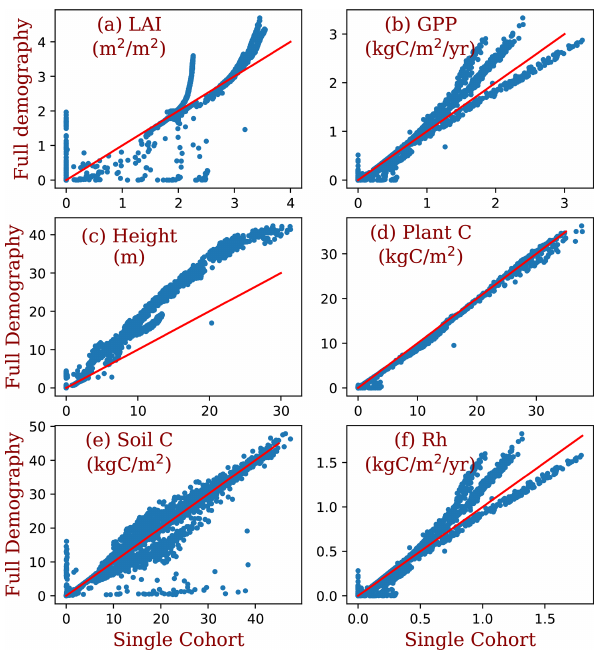
Figure 11. Comparison between the simulations of the full demog- raphy and the single-cohort settings of BiomeE. LAI is the leaf area index, GPP is the gross primary production (kgCm 2 yr − 1 ), height is the maximum tree height, plant C is the vegetation biomass (kgCm − 2 ), soil C is the soil organic matter (kgCm − 2 ), and R h is the heterotrophic respiration rate (kgCm − 2 yr − 1